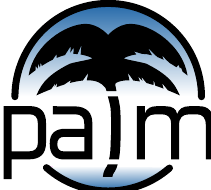
Figure 1. The PALM logo introduced in version